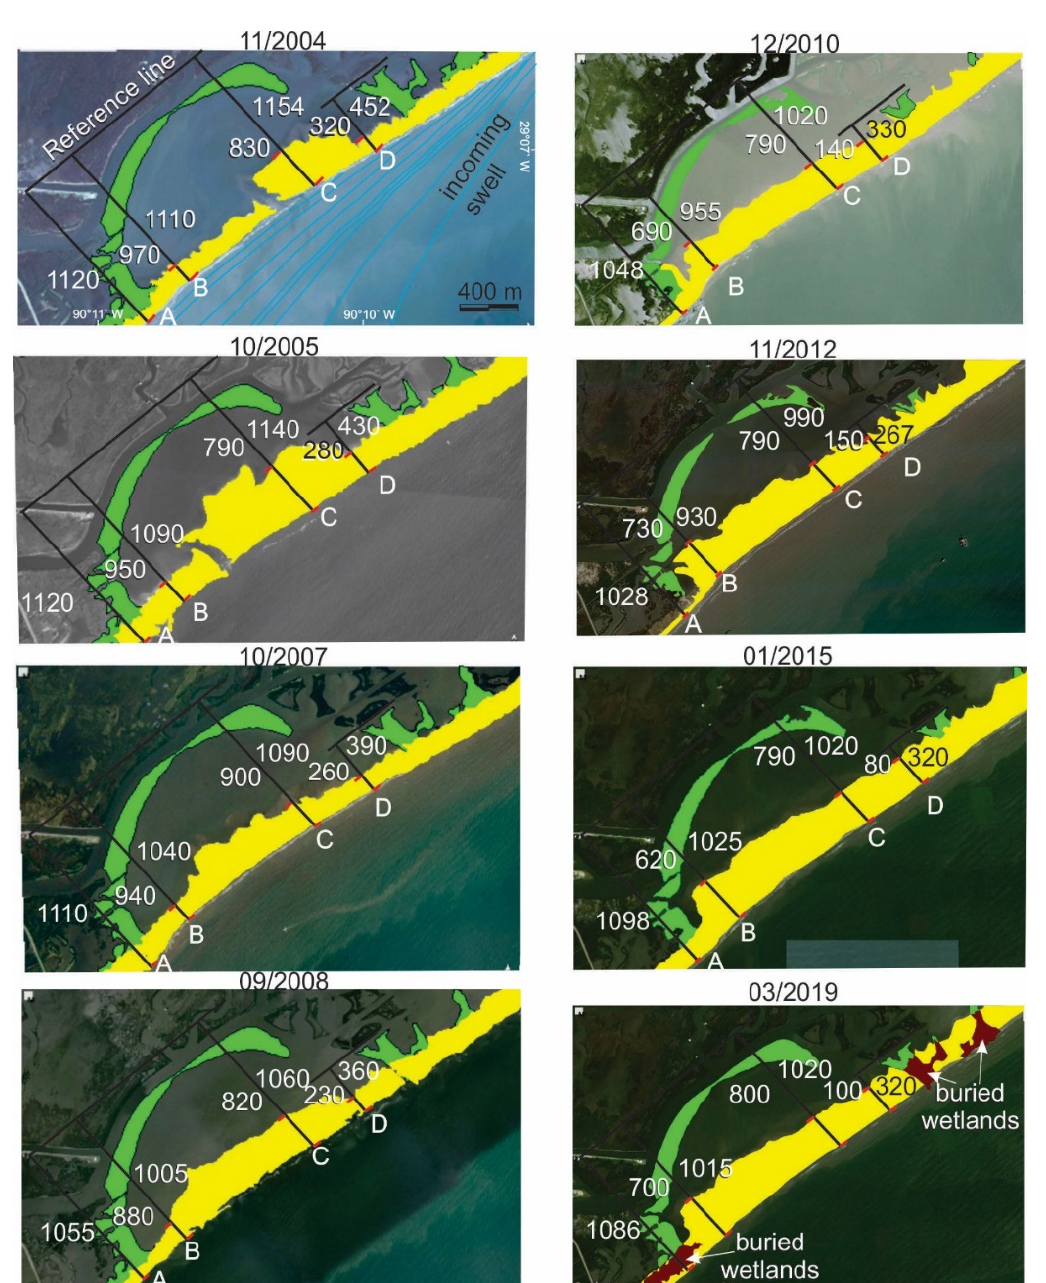
Figure 4. Spatial temporal analysis of the dynamics of the beach barrier, based on satellite images between 2004 and 2019. The numbers indicate the retreat and advance (m) of distal and proximal limits of the shoreline, based on the planimetric transects A, B, C, and D. For each transect (except A) there is a pair of numbers, the smaller number (e.g., 700 in transect B for 03/2019) refers to the proximal position of the shoreline, whereas the greater number (e.g., 1015 in transect B for 03/2019) refer to the distal position. There is only one number in transect A because it only has a distal shoreline position, and the proximal position ends in mangrove wetlands. Margin of error is ± 2.5 m.